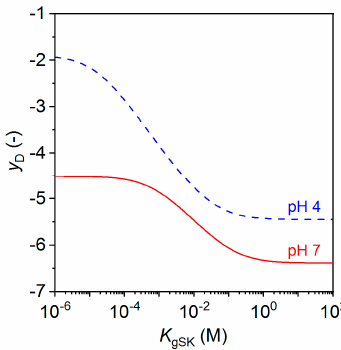
Figure 3. Dimensionless Donnan potential, y D , vs gel sulfate-potassium dissociation constant, K gSK , for different pH values. Reprinted from [37] with permission, Copyright 2018, Wiley-VCH Verlag GmbH & Co., 2018.